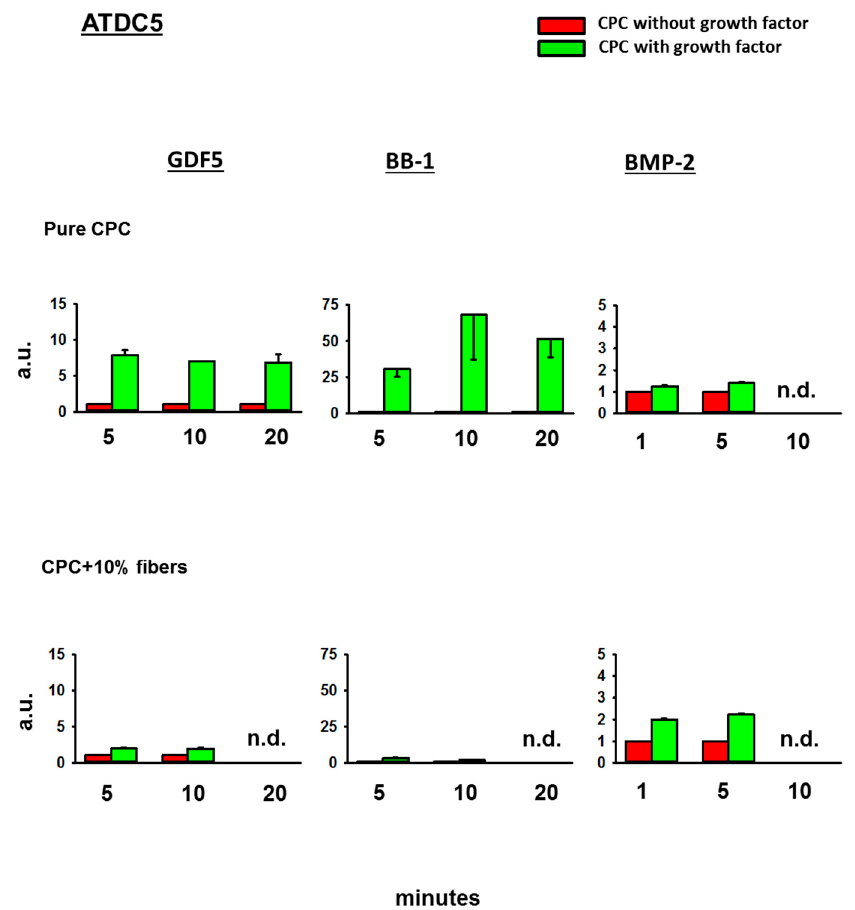
Figure 7. Alkaline phosphatase (ALP) activity in ATDC5 cells. ATDC5 cells were cultivated for 3 days in diluted extracts of GDF5, BB-1, or BMP-2-containing, ground pure CPC or PLGA fiber-reinforced CPC. Thereafter, the ALP activity was measured using an ALP assay and the data were expressed as fold-change induction compared to the CPC without growth factor; data are expressed as means ± SEM ( n = 3); n.d. = not determined; a.u. = arbitrary units.